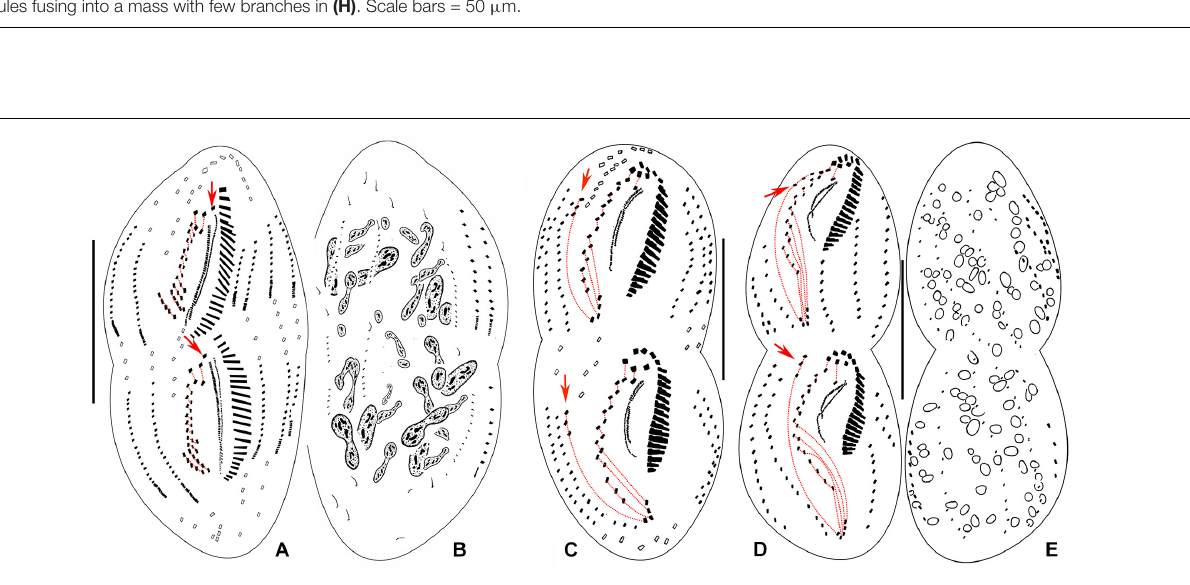
Frontiers in Marine Science |